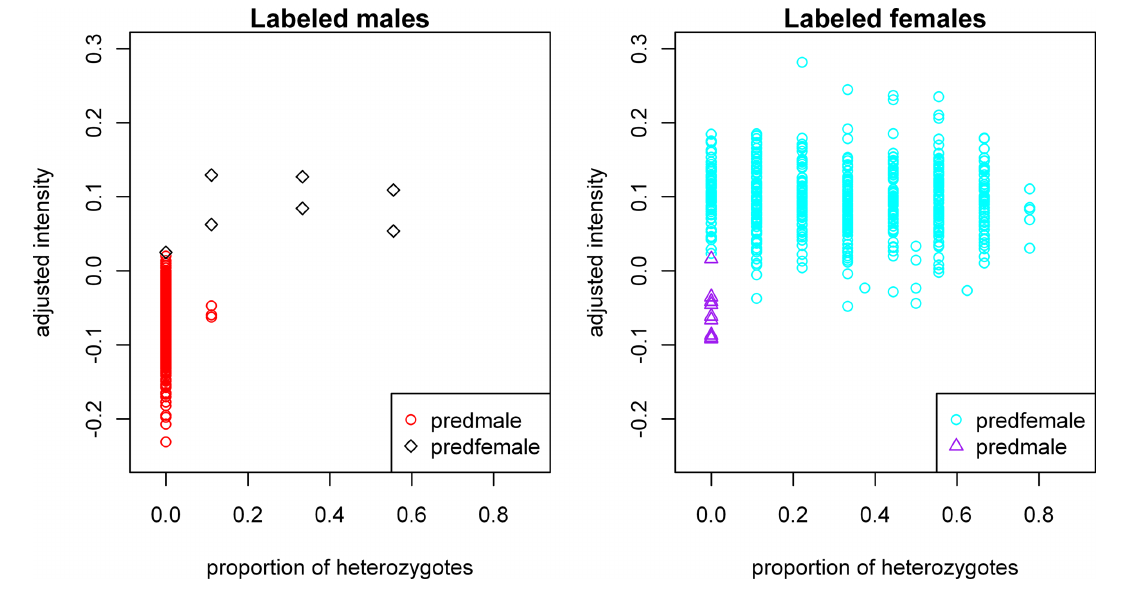
FIGURE 2 | Plot of gender-labeling errors predicted by our approach. Subjects in the left panel are labeled male samples; “predfemale”: predicted probability of being male less than 0.5. Subjects in the right panel are labeled female samples; “predmale”: predicted